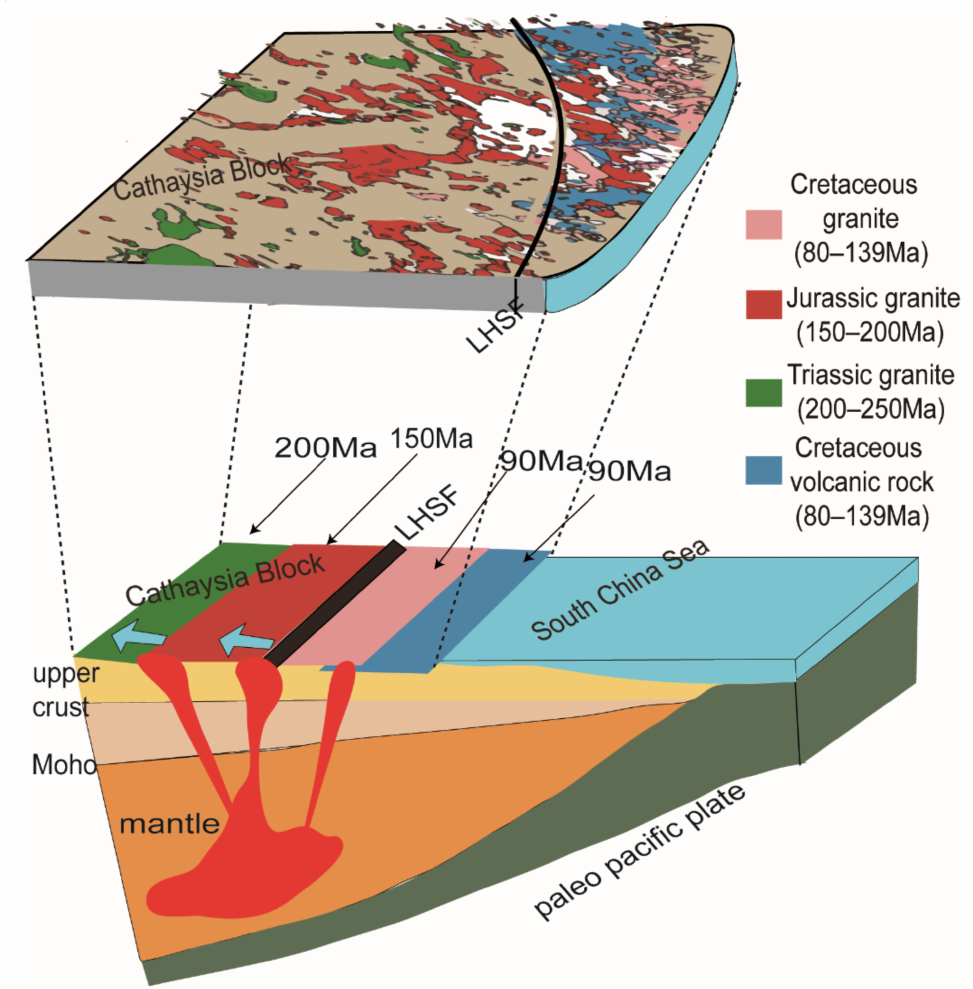
Figure 10. Modeling of several intrusive rocks. Since 250 Ma, the CASC has been subjected to three magmatic intrusions: Triassic granite (250–200 Ma), Jurassic granite (200–150 Ma), and Cretaceous granite and Cretaceous volcanic rocks (139–80